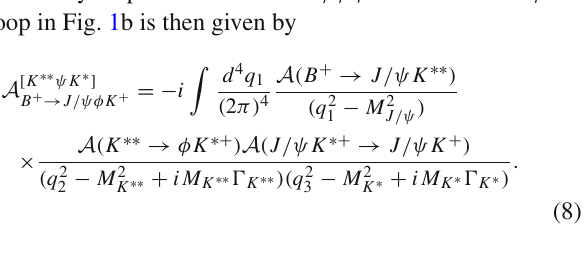
Fig. 2 Invariant mass distribution of J /ψ K + via the rescattering pro- cesses in Fig. 1. For a : The mass and width of intermediate state X are taken to be those of X ( 4140 ) (solid line), X ( 4274 ) (dotted line), and X ( 4685 ) (dashed line) given by LHCb [1], separately. For b : The